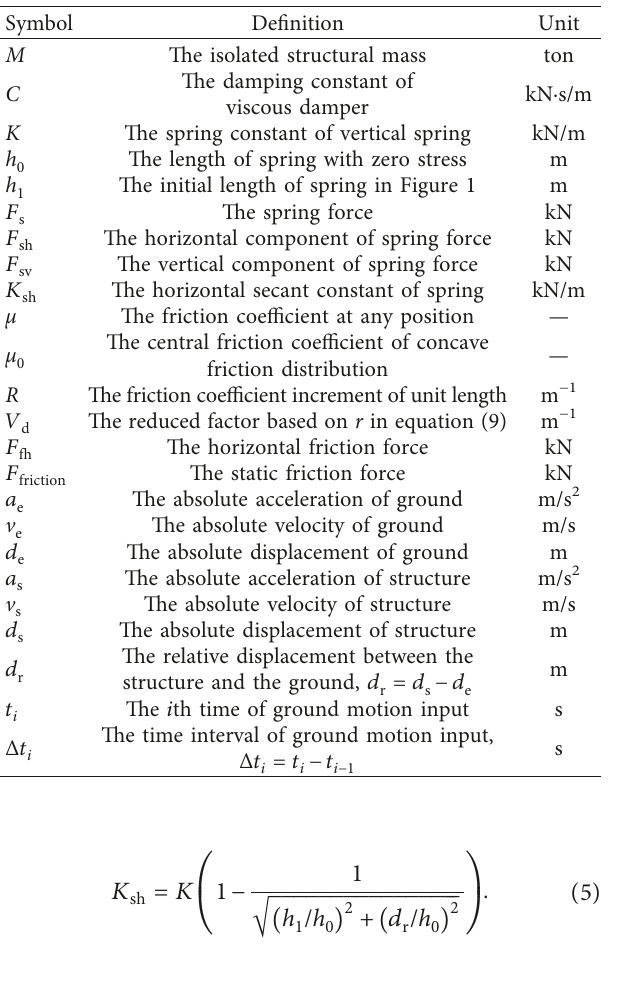
Table 1: Parameters of the system in Figure